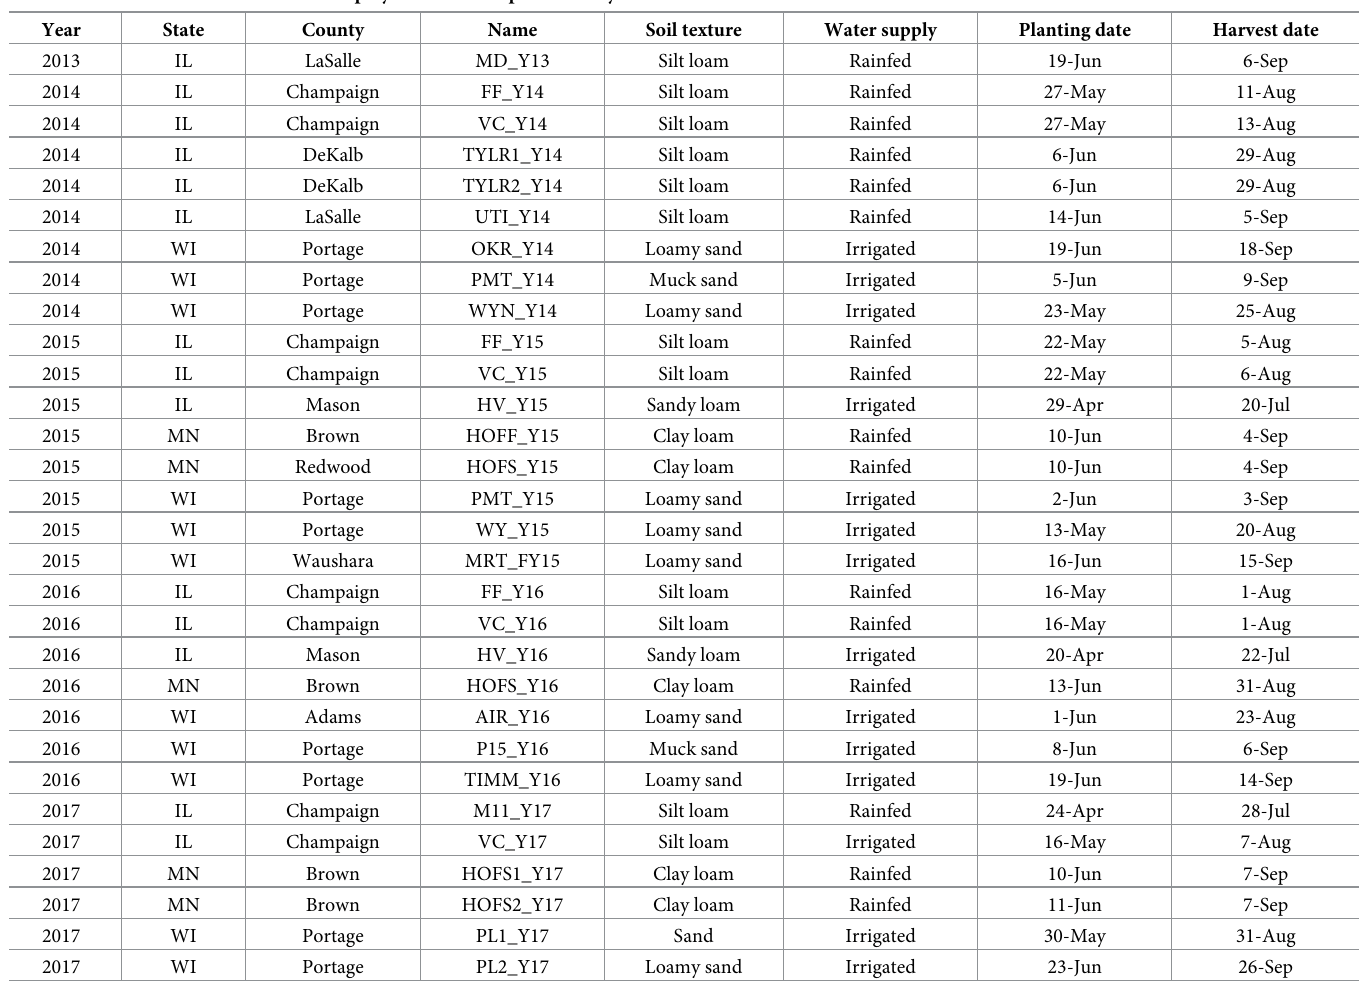
Table 1. Site characterization of fields employed in on-farm plant density